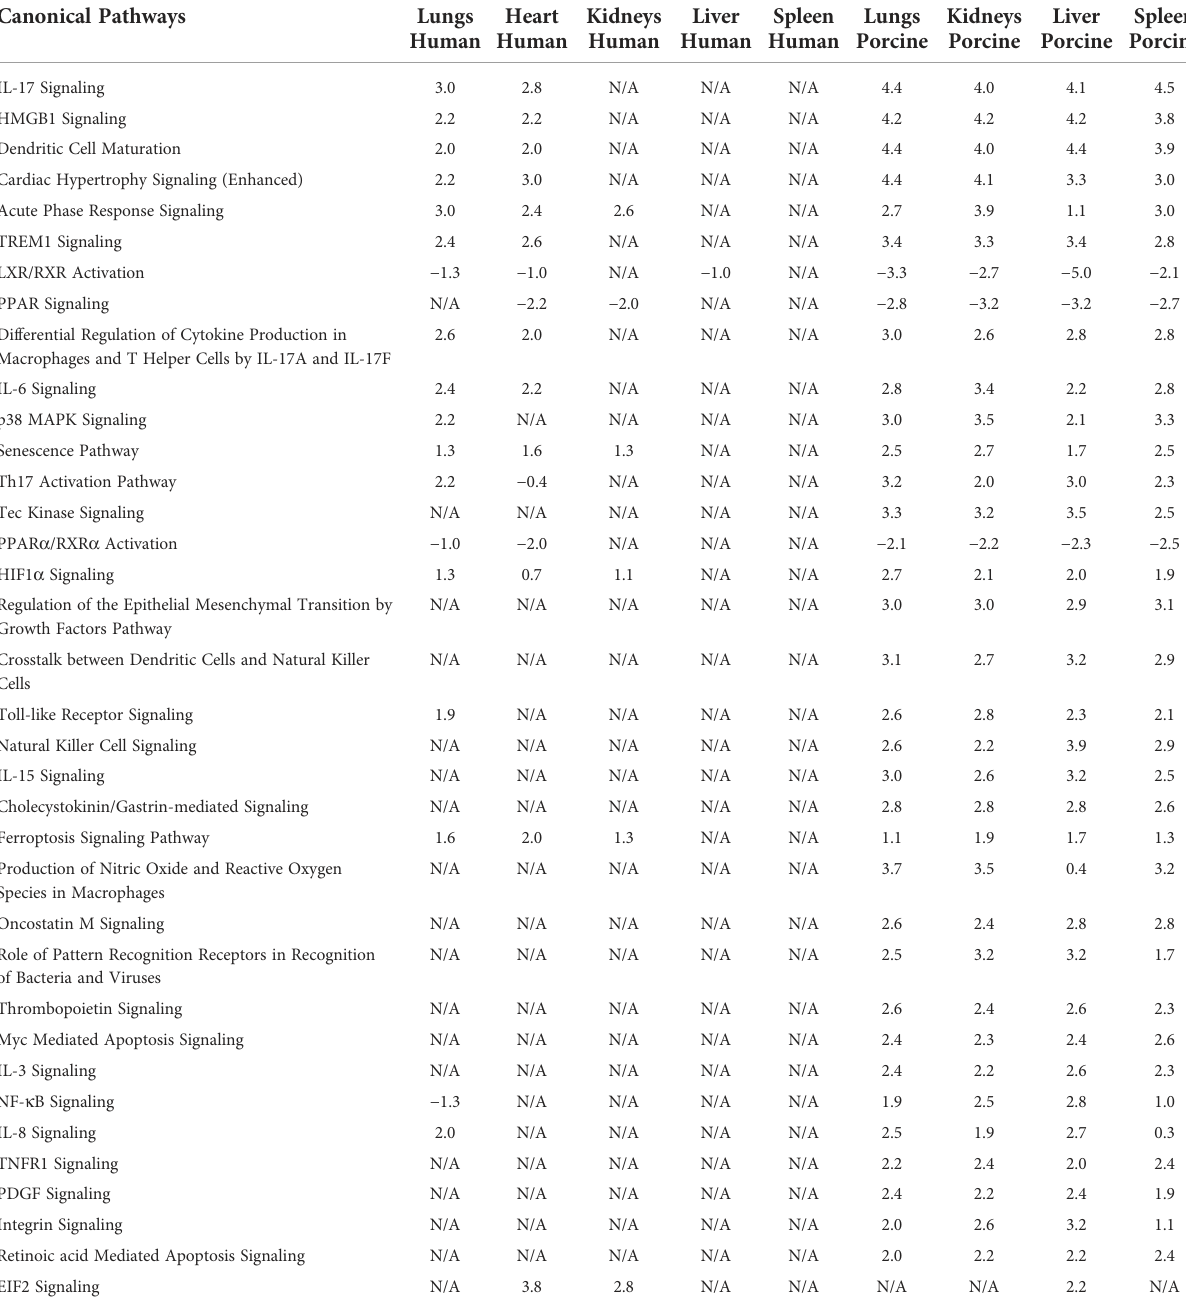
TABLE 5 Predicted canonical pathways based on Z-score values in FFPE tissue samples from patients with meningococcal septic shock and in organs from porcinis infused with exponentially increasing numbers of N. meningitidis (reference strain H44/76) vs.